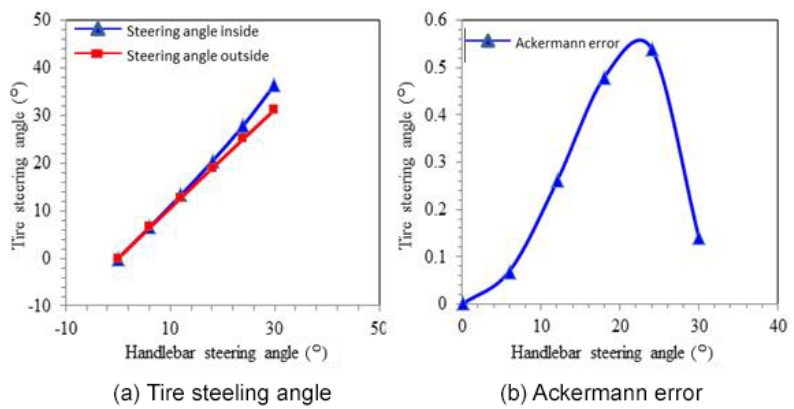
Figure 15. Simulation result of the tire steering angle.